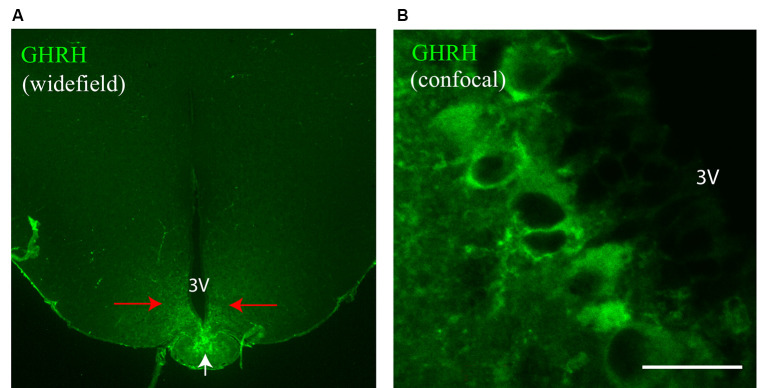
GH-Releasing Hormone (GHRH) neurons in the mouse brain. (A) A widefield overview image of a mouse brain section stained with an antibody against GHRH. The staining is specific to the arcuate nucleus (red arrows) and the median eminence (white arrow). (B) A confocal image of GHRH-stained neuronal bodies in the arcuate nucleus. 3V, third ventricle. Scale bar = 20 μm.